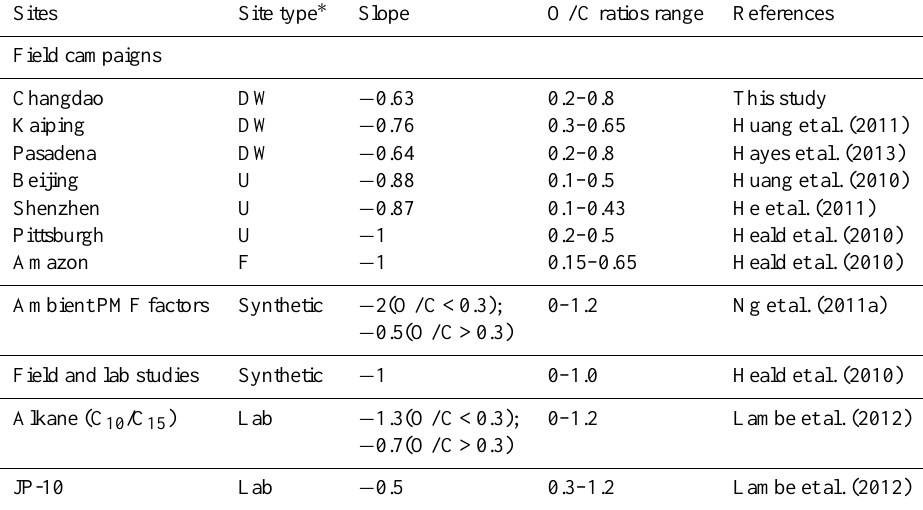
Table 3. Summary of the slopes (H/C ratios vs. O/C ratios) determined from ambient and laboratory studies in the van Krevelen